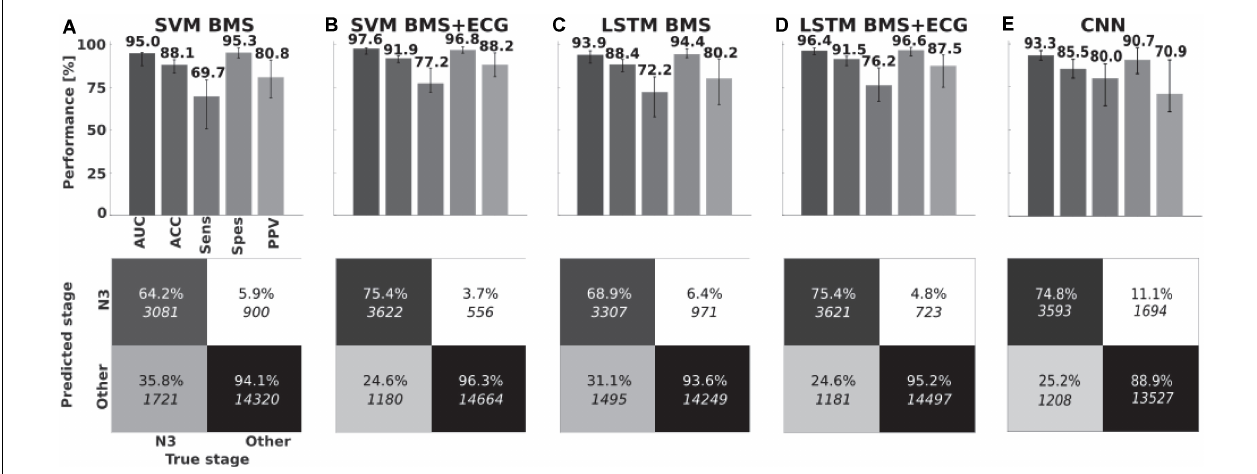
FIGURE 3 | Classifier performances. Medians, interquartile ranges and pooled confusion matrices for (A) BMS feature-based Support Vector Machine classifier and (B) with ECG feature extension. (C,D) Long Short-Term Memory neural networks with same features. (E) Convolutional neural network on bed mattress signal. Area Under Receiving Operating Character Curve (AUC), accuracy (ACC), Sensitivity (Sens), Specificity (Spes), and positive predictive value (PPV).